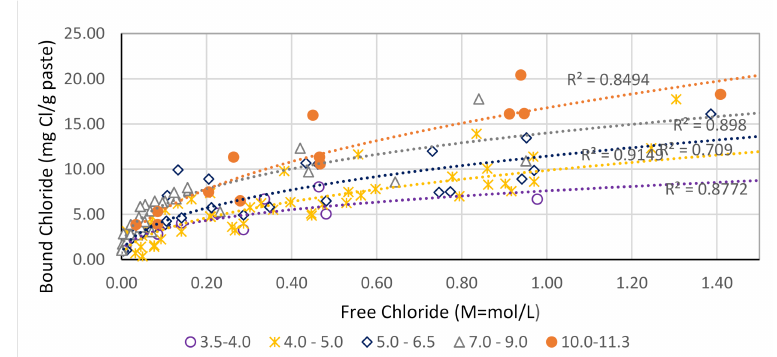
Figure 3. Relationship between bound and free chloride for concrete with di ff erent Al 2 O 3 content.